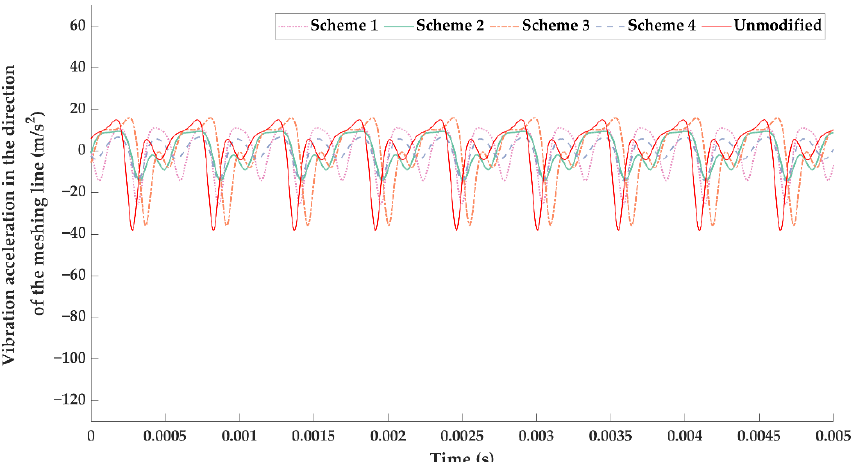
Figure 22. Vibration acceleration in the direction of the gear meshing line at a load of 200 N·m.